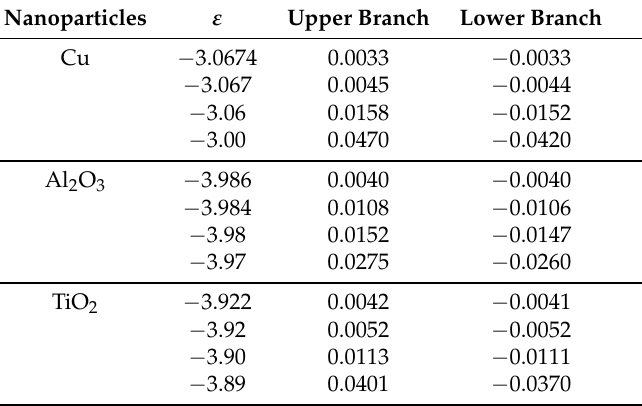
Table 3. Smallest eigenvalues γ for different nanoparticles and for various values of velocity ratio parameter ε when φ = 0.1, c = 0.1 and λ = − 0.2 for Cu